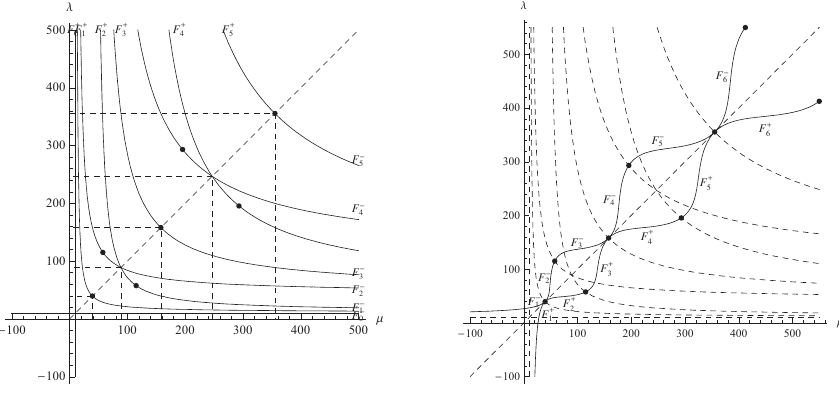
Figure 1. The spectrum for the problems (1.1), (1.2) and (1.1),